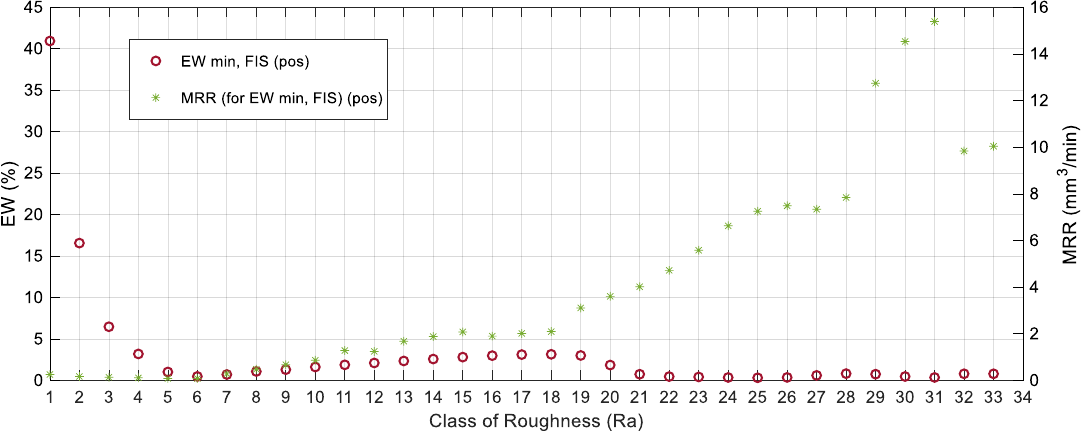
Figure 18. Values obtained from the technological table with the fuzzy inference system for the strategy of minimum electrode wear using positive polarity.